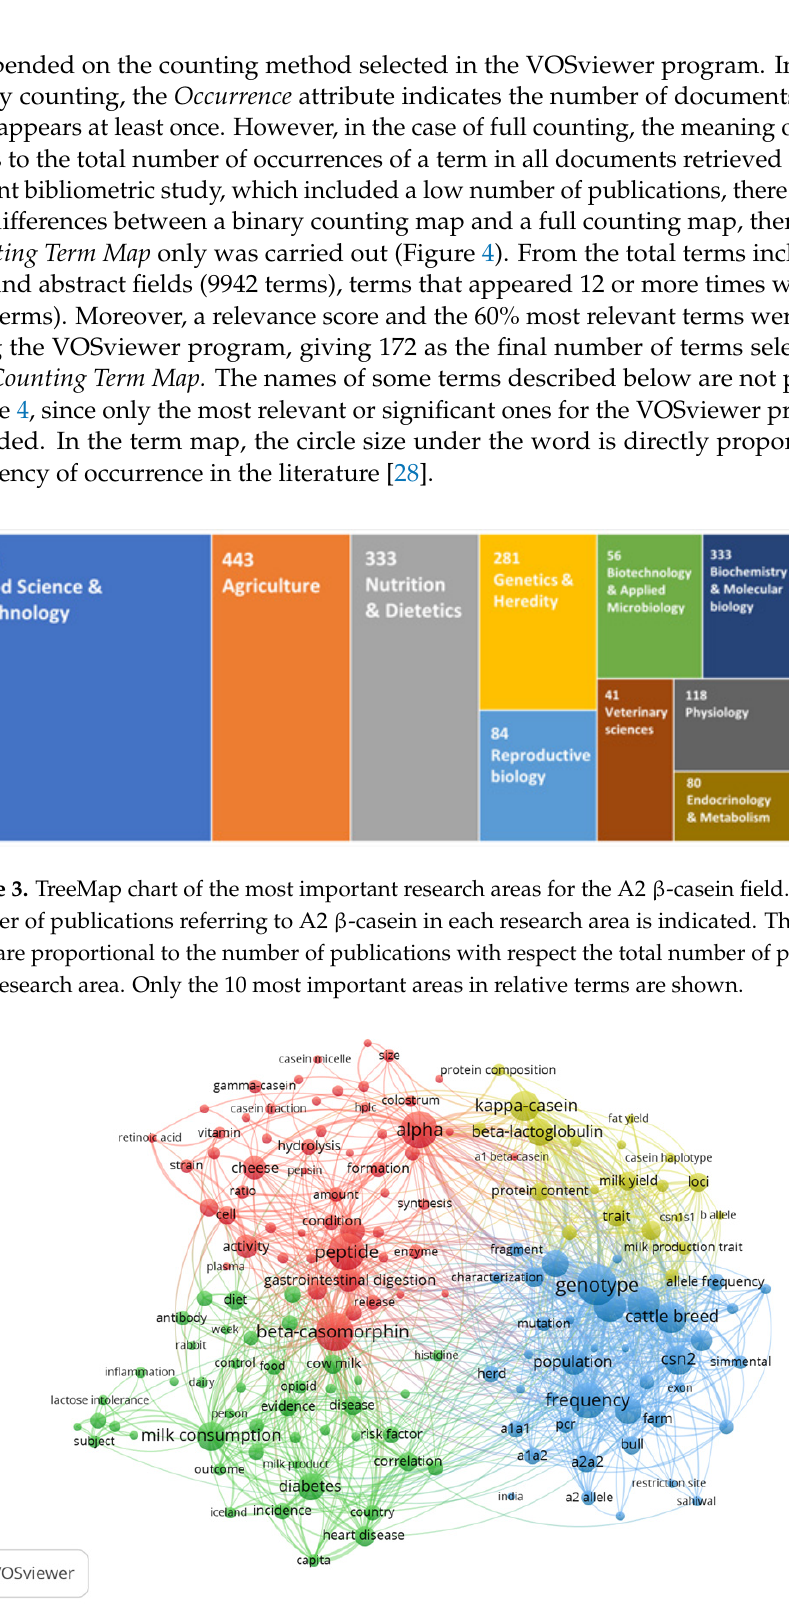
Figure 4. Terms clouds based on worldwide A2 β -casein research. Terms used more than 12 times in titles and abstracts. The size of the circle under the word indicates the term frequency. The four clusters represent the relationship between the items. Each cluster is represented with a different color by the VOSviewer program.